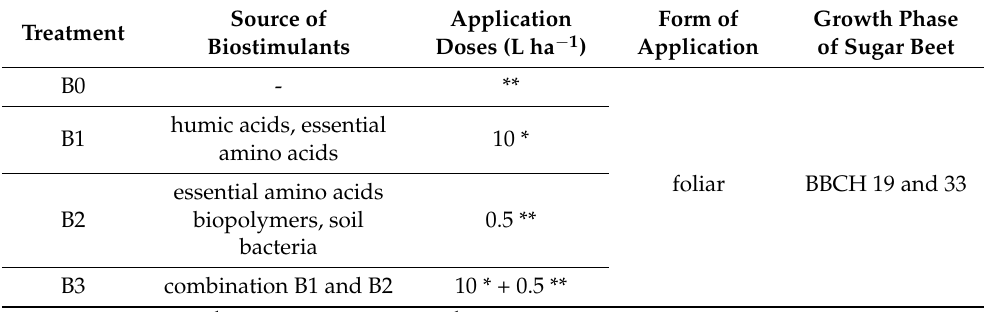
Table 4. Biostimulants treatment application. Treatment